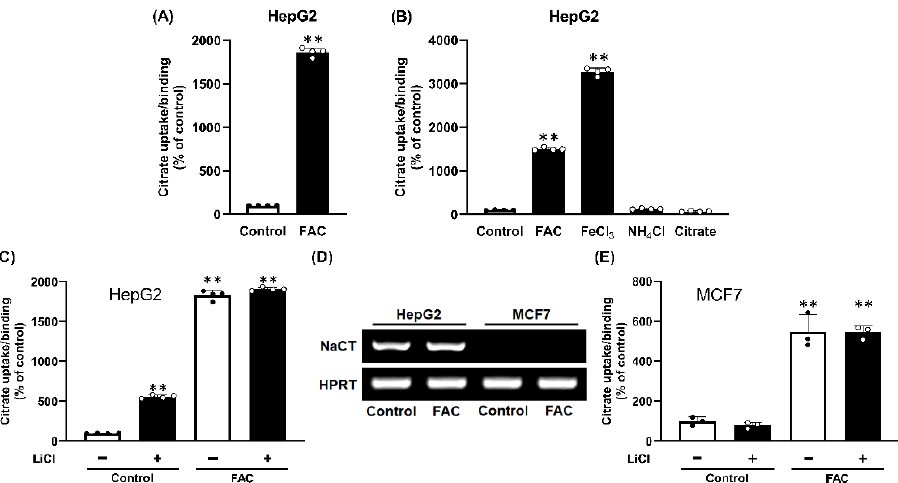
Figure 1. Effect of pretreatment with Fe 3+ on citrate uptake/binding in the human hepatocarcinoma cell line HepG2 and the human breast cancer cell line MCF7. ( A ) HepG2 cells were cultured in the absence or presence of FAC (65 µ g/mL) for two passages. The cells were then seeded for uptake/binding measurements and cultured in the absence or presence of FAC; confluent cells were used for [ 14 C]-citrate (3.5 µ M) uptake/binding (NaCl buffer, pH 7.5; 15 min incubation). ( B ) HepG2 cells were cultured in the absence or presence of FAC (250 µ g/mL), FeCl 3 (1 mM), NH 4 Cl (1 mM) or citrate (1 mM) for two passages. The cells were then seeded for uptake/binding measurements and cultured in the absence or presence of FAC, FeCl 3 , NH 4 Cl or citrate. Confluent cells were used for [ 14 C]-citrate (3.5 µ M) uptake/binding (NaCl buffer, pH 7.5; 15 min incubation). ( C ) To determine the potential involvement of NaCT in the Fe 3+ -stimulated citrate uptake/binding in HepG2 cells, the effect of Li + , an activator of NaCT transport, was studied. The cells were cultured in the absence or presence of FAC (250 µ g/mL) for two passages. The cells were then seeded for uptake/binding experiments and cultured in the absence or presence of FAC; confluent cells were used for [ 14 C]-citrate (3.5 µ M) uptake/binding (NaCl buffer, pH 7.5; 15 min incubation) in the absence or presence of 10 mM LiCl. ( D ) Expression of NaCT mRNA in control and FAC-exposed HepG2 and MCF7 cells as assessed by RT-PCR. ( E ) Absence of Li + -dependent increase in citrate uptake/binding in MCF7 cells. The experimental protocol was same as the one described above for HepG2 cells. **, p <